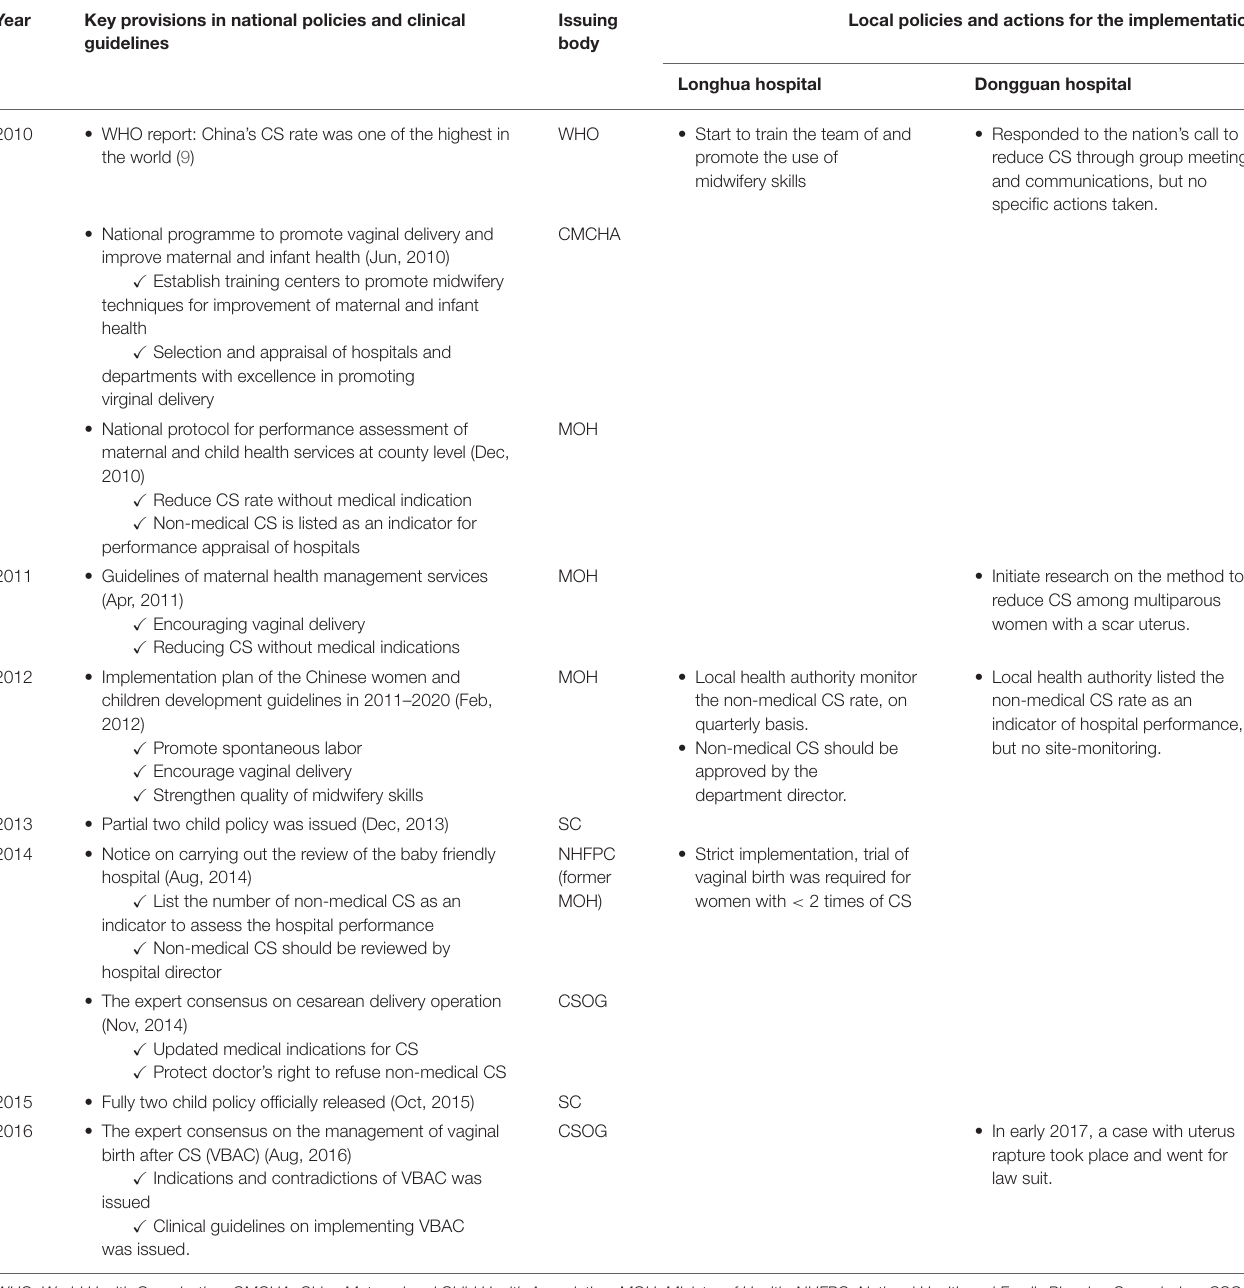
TABLE 1 | The relevant national policies/clinical guidelines and local policies and actions for the